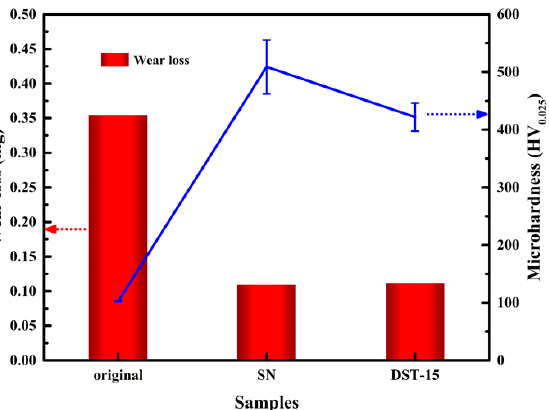
Figure 9. Comparison of the wear loss and microhardness of the original material, the SN sample, and the DST-15 sample.